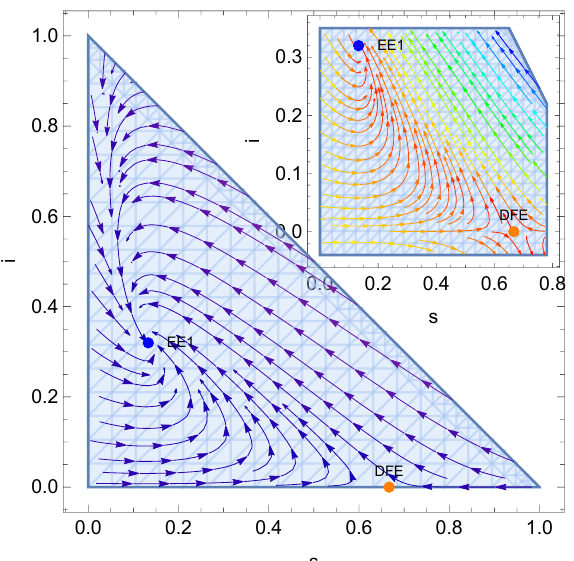
Figure 2. Stream plots of ( s , i ) for the scaled model (13) illustrating the case when γ s is less than the critical vaccination γ ∗ s defined in (24) , EE1 is a stable equilibrium point, DFE is a (boundary) saddle point, and EE2 is outside the